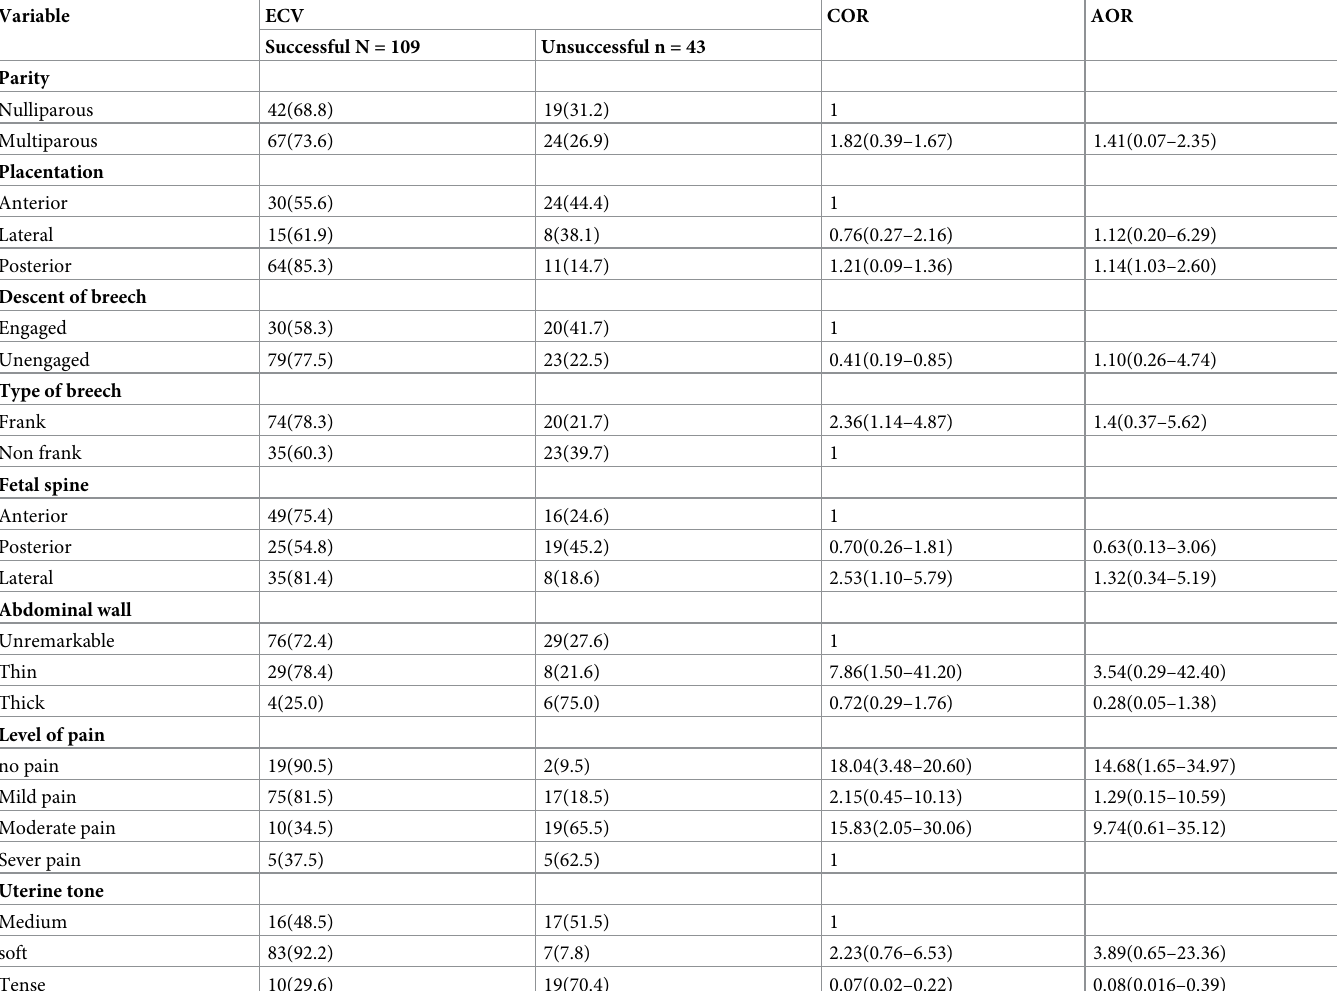
Table 4. Multivariate logistic regression analysis of factors associated with success of